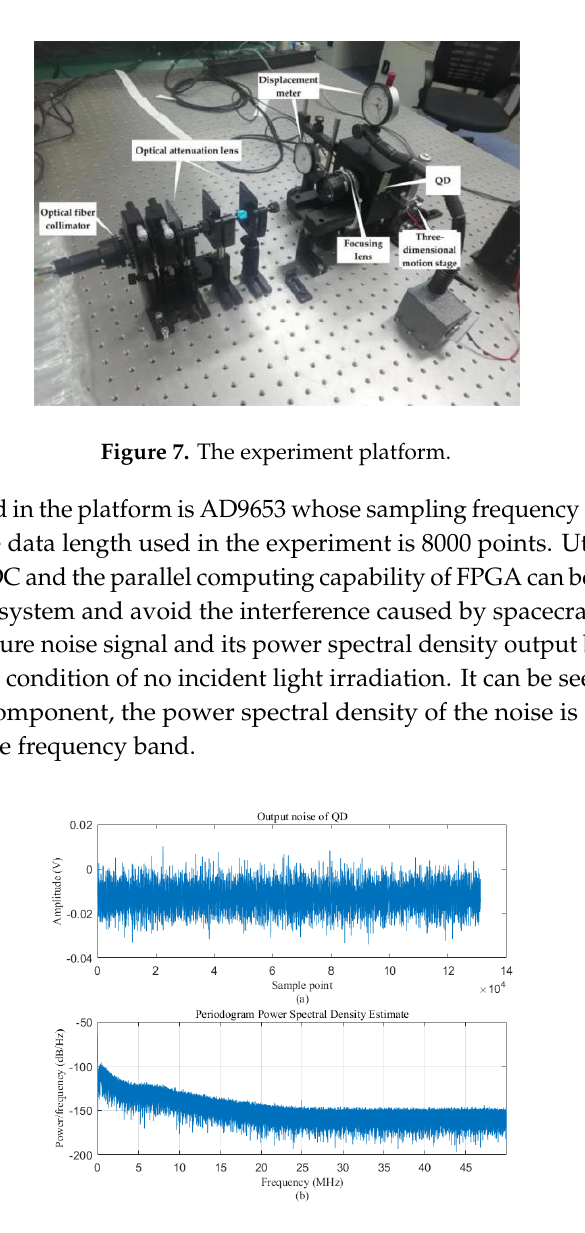
Figure 8. The output noise of the QD and its power spectral density (PSD).